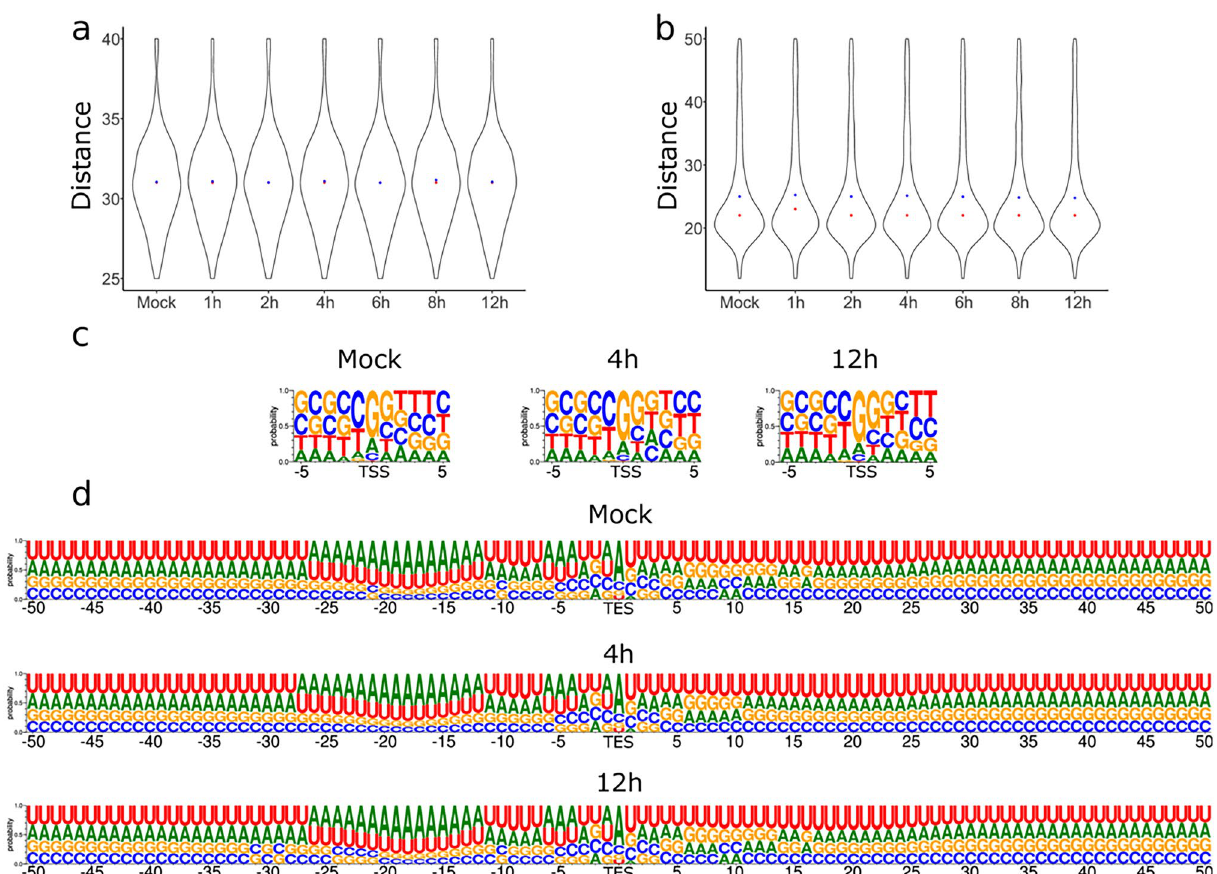
Figure 1. The effect of viral infection on transcript start and end sites. ( a ) The distance of TATA boxes from TSSs and ( b ) the distance of polyadenylation signals from TESs in base pairs. The sequence motif of the ( c ) TSSs and the ( d ) TESs in the mock infected cells, 4 h and 12 h following infection. Panels (a) and (b) were created using R v. 3.6.3 (https:// www.r- proje ct. org/) and ggplot2 v. 3.3.3 (https:// ggplo t2. tidyv erse. org/ refer ence/ ggplot. html). Panels ( c ) and ( d ) were created using the online tool WebLogo3 (http:// weblo go. three pluso ne. com/). The figure was created using Inkscape v. 0.92 (https:// inksc ape.